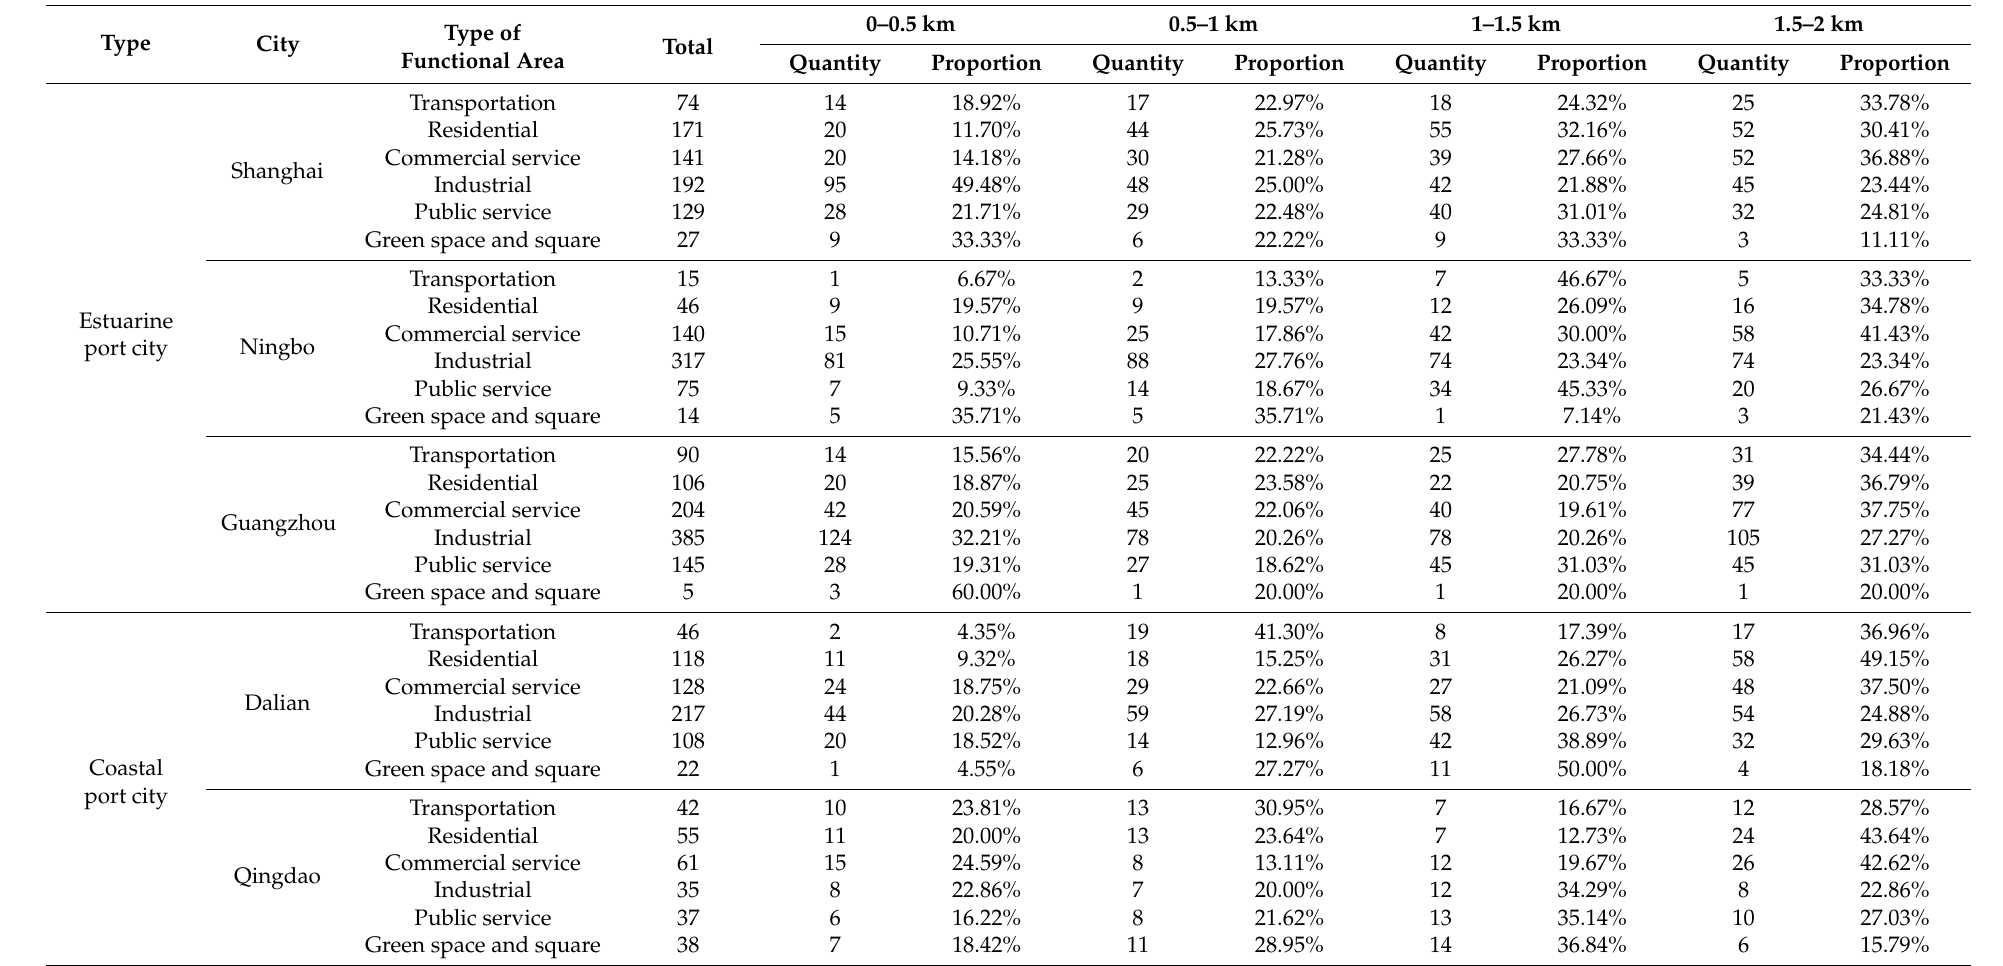
Table 4. Number and proportion of urban functional areas in the port–city